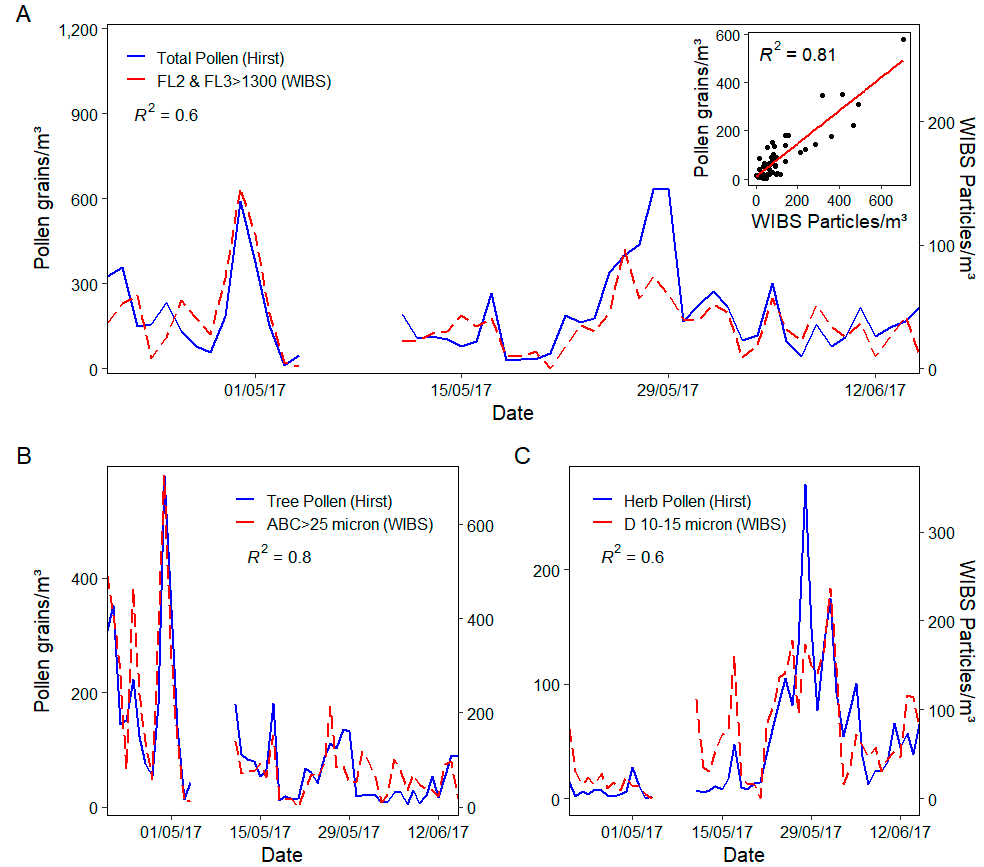
Figure 7. ( A ) Daily time series and embedded linear regression of Hirst total pollen vs. WIBS Particle concentrations with FL2 and FL3 intensity greater than 1300, ( B ) Daily time series of Hirst tree pollen vs. WIBS ABC (greater than 25 µm) particle concentrations and ( C ) Daily time series of Hirst herb pollen vs. WIBS D (10–15 µm) particle concentrations.